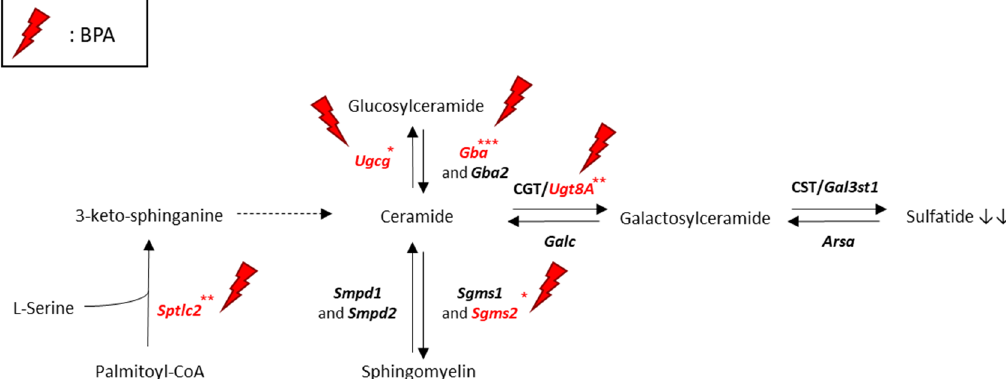
Figure 5. Impact of BPA on sphingolipid metabolism. Adapted from [19,20]: Genes impacted by exposure to BPA 10 µM according to RT-qPCR analysis: serine palmitoyltransferase long chain base subunit 2 ( Sptlc2 ), arylsulfatase A ( Arsa ), galactosylceramidase ( Galc ), sphingomyelin synthase 1 ( Sgms1 ), sphingomyelin synthase 2 ( Sgms2 ), UDP-glucose ceramide glucosyltransferase ( Ugcg ), glucosylceramidase beta ( Gba ), glucosylceramidase beta 2 ( Gba2 ), UDP-galactosyltransferase ( Ugt8a ), sphingomyelin phosphodiesterase 1 ( Smpd1 ), sphingomyelin phosphodiesterase 2 ( Smpd2 ) (one- way ANOVA and Dunnett multiple comparison post-test , * p < 0.05, ** p < 0.01, and *** p < 0.001).